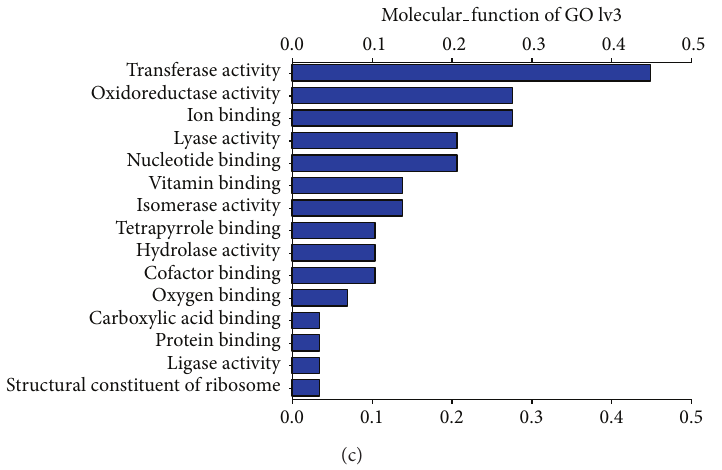
Figure 2: Partial results of GO annotations obtained using FastAnnotator . These horizontal bar charts represent the distribution of GO terms categorized as biological process (a), cellular components (b), and molecular functions (c).